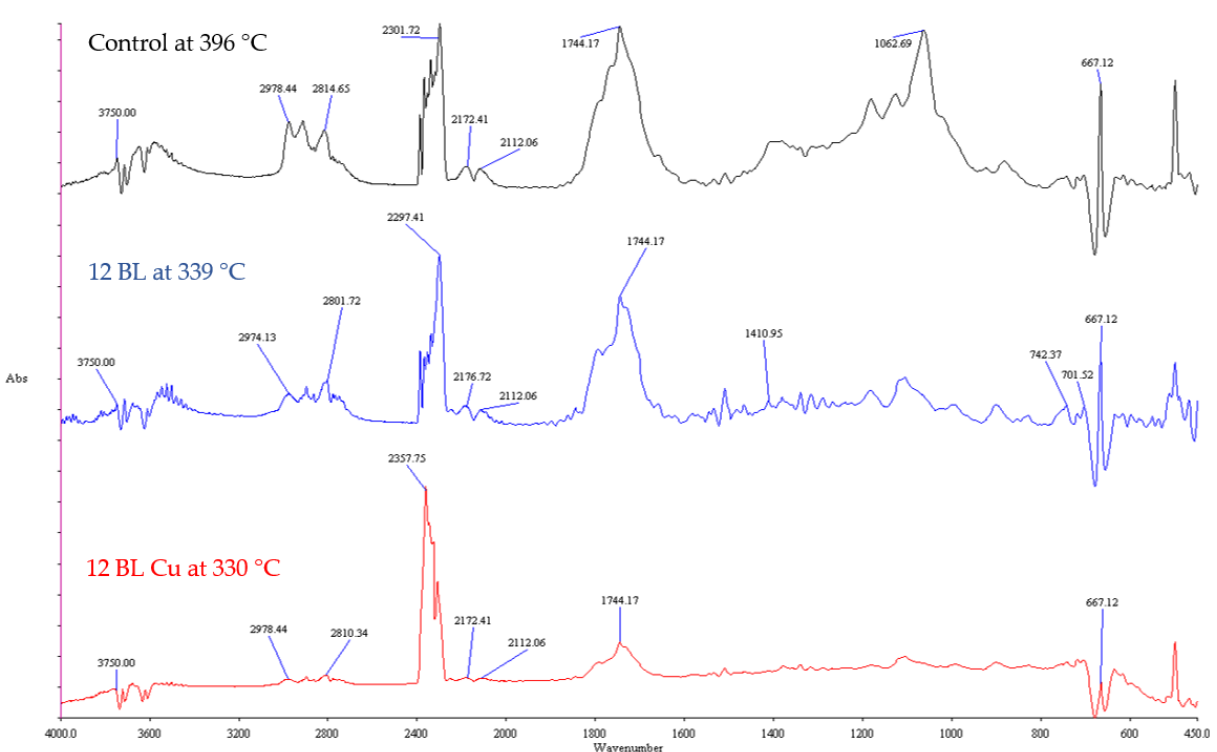
Figure 5. IR spectra of untreated and 12 BL-treated cotton at the first decomposition stage (T 1 ).